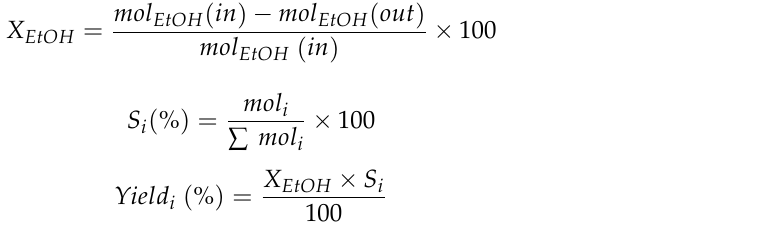
Figure S1: SEM images of activated carbon-supported metal catalysts, Figure S2: EDX of metal on commercial activated carbons, Figure S3: FTIR spectra of activated carbon-supported metal catalysts, Figure S4: Thermal analysis of activated carbon-supported metal catalysts, Figure S5: TPR profiles of activated carbon-supported metal catalysts. Table S1: %metal content of the different commercial activated carbon catalysts, Table S2: Functional group of activated